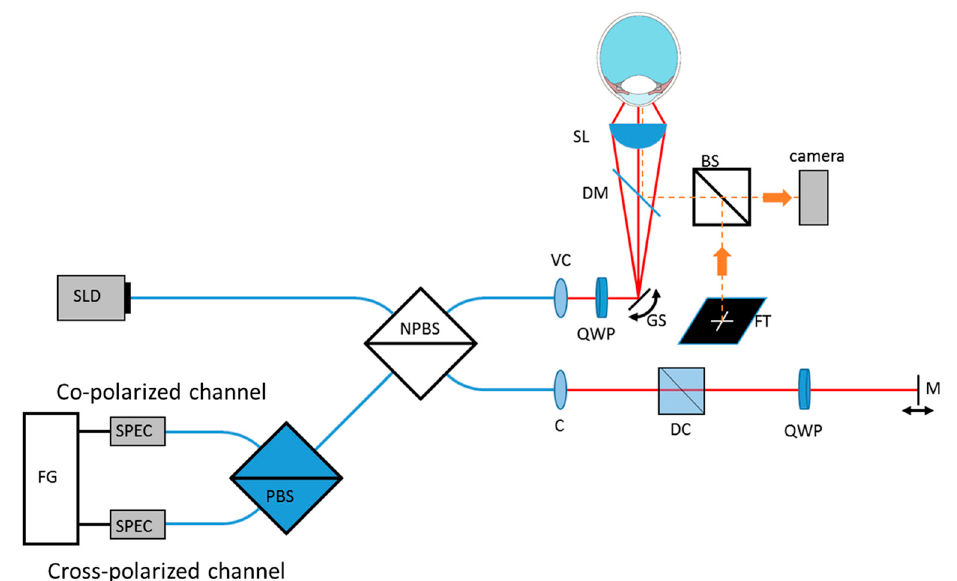
Figure 1. Scheme of the optical setup. SLD (superluminescent diode), NPBS (non-polarizing fiber based beam splitter), VC (variable collimator), QWP (quarter wave plate), GS (galvanometer scanner), DM (dichroic mirror), SL (spherical lens), BS (beam splitter), FT (fixation target), C (collimator), DC (dispersion compensation), M (mirror), PBS (polarizing beam splitter), SPEC (spectrometer), FG (frame grabber). All fibers are polarization maintaining.